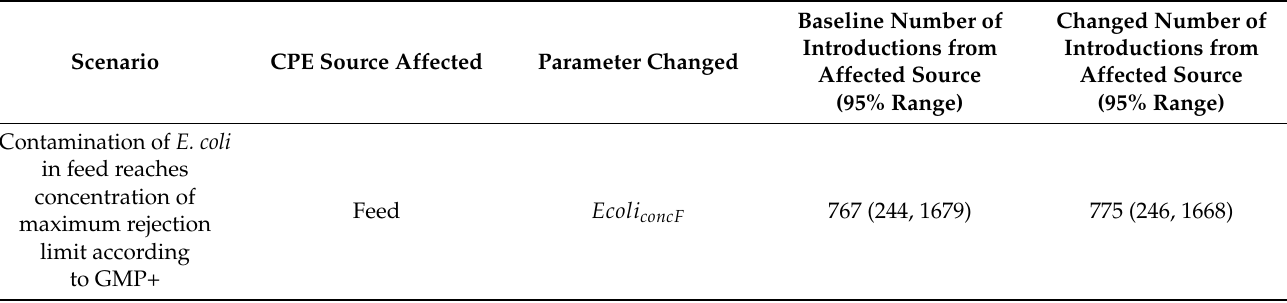
Table 3. What-if analysis related to probability of colonization in feed, restriction on import of animals from countries with weak surveillance for CPE , and less strict biosecurity practice in local